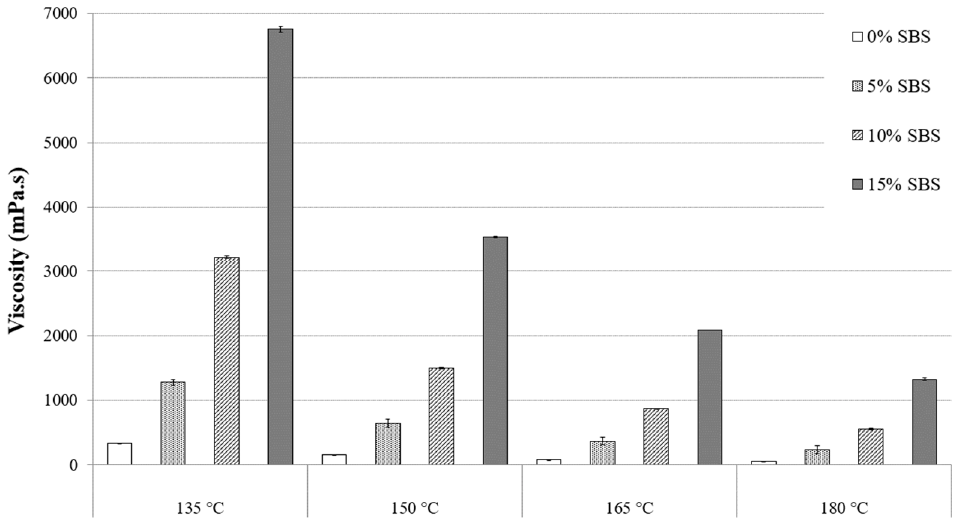
Figure 2. Viscosity of PG 64 ‐ 22 binders with 6% processed oil as a function of SBS content.